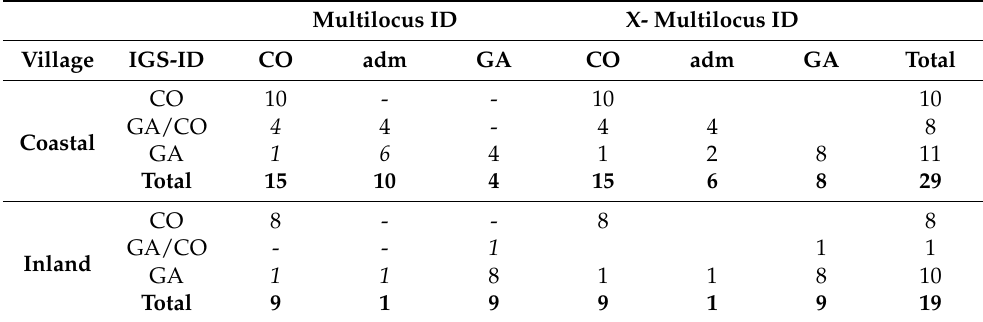
Table 2. Results of multilocus genotyping of IGS- An. Gambiae, IGS- An. Coluzzii, and IGS-hybrid specimens from the coastal (Ayame) and the inland (Petessou) villages in C ô te d’Ivoire. Left panel: results from genotyping of 18 Ancestry Informative Markers (AIMs, [21]) on chromosomal arms X, 2R, 3R, and 3L. Individuals are defined as admixed (adm) when at least 1 locus on chromosome- X or >1 out of 8 autosomal loci is not consistent with the other loci. Right panel: results from genotyping of 10 AIMs on chromosome-X. Individuals are defined as admixed (adm) when at least 1 locus is non consistent with the other loci. Italics = specimens identified discordantly by the IGS- and the multilocus